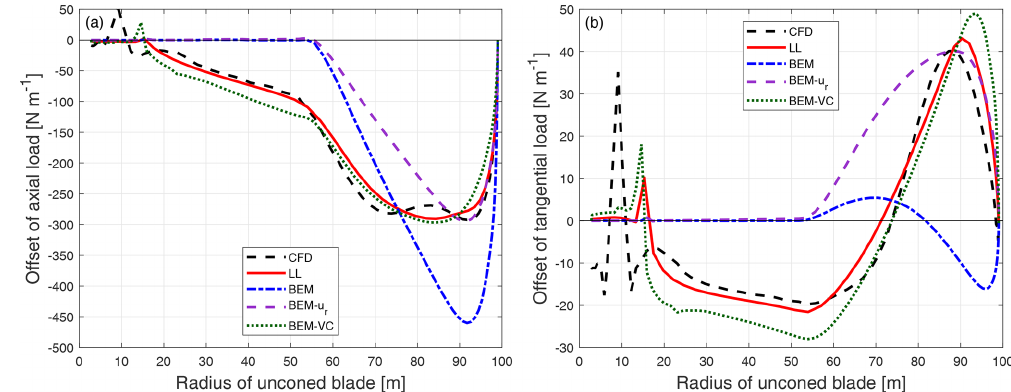
Figure 14. Comparison of the difference of the axial load (a) and tangential load (b) of the dihedral blade W-1 with 15 ◦ of cone upwind compared to the baseline blade with the same cone calculated from CFD, the lifting-line method (LL), the BEM method, BEM with radial induction (BEM- u r ) and the proposed BEM-VC method.